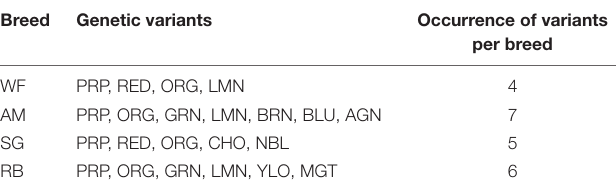
TABLE 3 | Distribution of genetic variants of HSP 70 gene within native cattle breeds of Nigeria. Breed Genetic variants Occurrence of variants